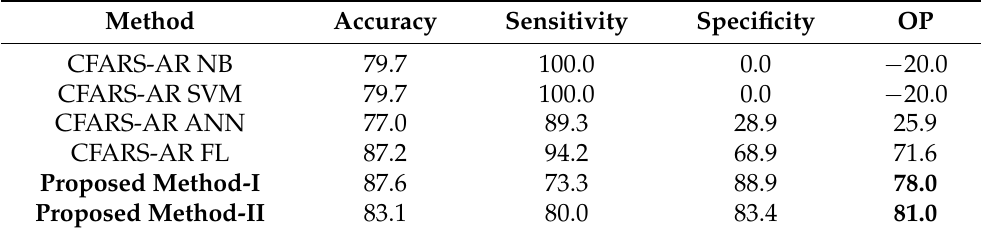
Table 2. Spectf Results.